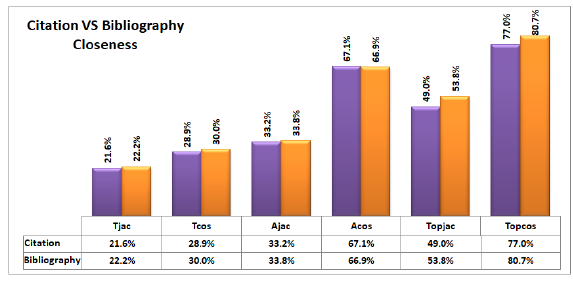
Figure 4. Comparison Between Citation and Bibliography Through Closeness